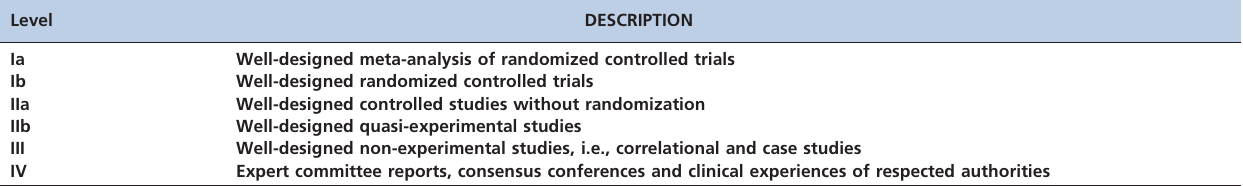
Table 1 - Levels of evidence of the treatment efficacy studies (ASHA,